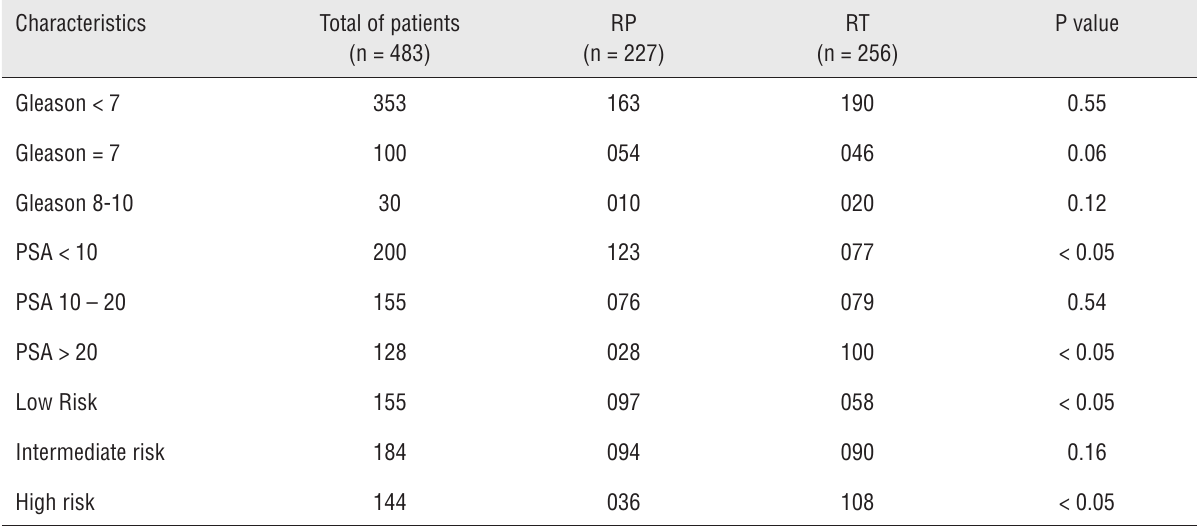
Table 2 - Risk factors and modality of treatment. Characteristics